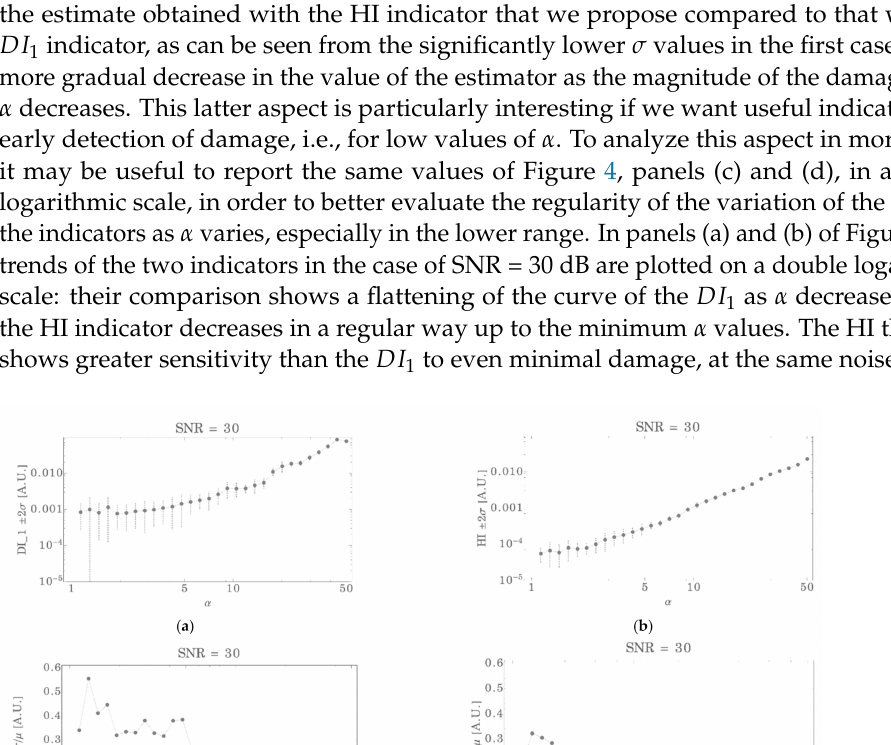
(cid:16) (cid:17) σ for HI @ SNR = 30 µ